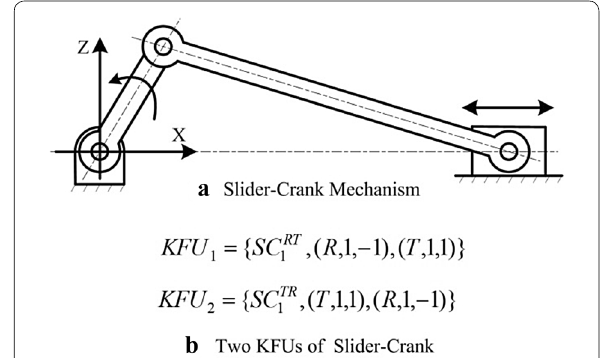
Figure 2 Representation of a slider-crank and its